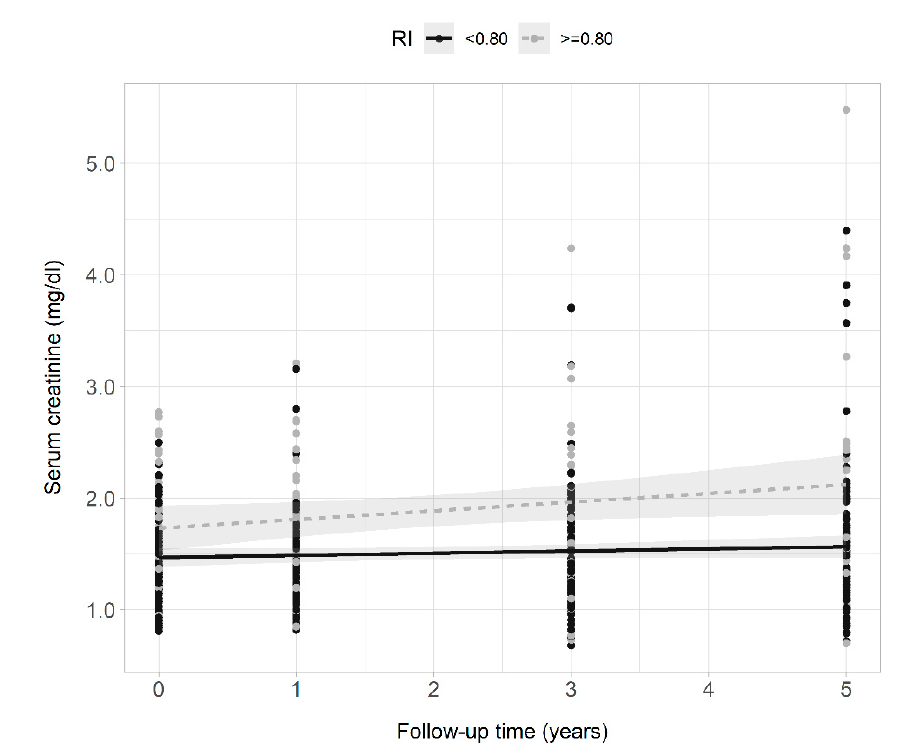
filtration rate by creatinine clearance. Intercept, regression line intercept; Interaction, interaction term in the regression analysis; Scaled, variable was mean centered and divided by standard deviation.